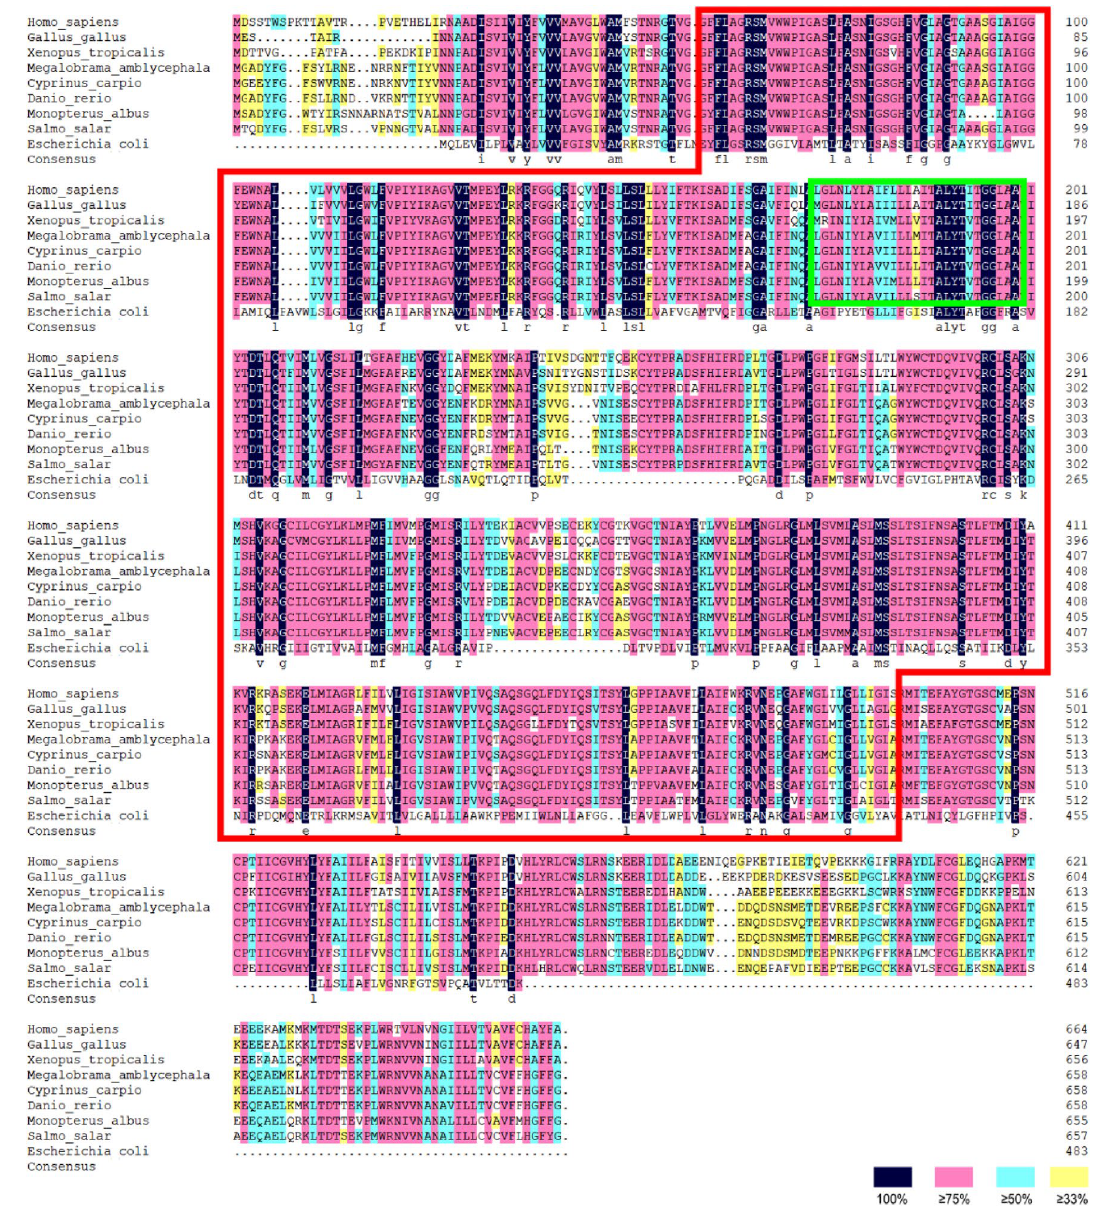
Figure 3. Homologous alignment of SGLT1 amino acid sequences in different species. The red box represents the SSF domain (PFAM00474), green box represents SSF protein characteristic conserved site NA_SOLUT_ symp_1